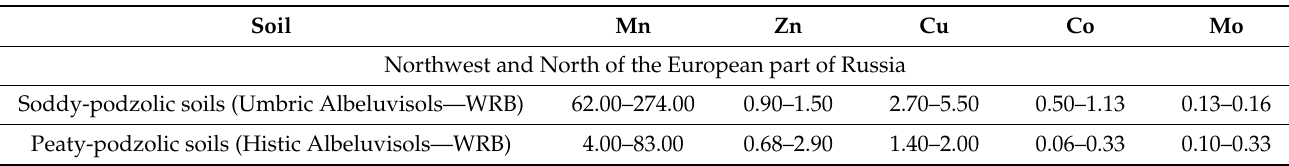
Table 2. Microelements mobile forms content in soils of the north-west of the European part of Russia, mg kg − 1 of air-dry